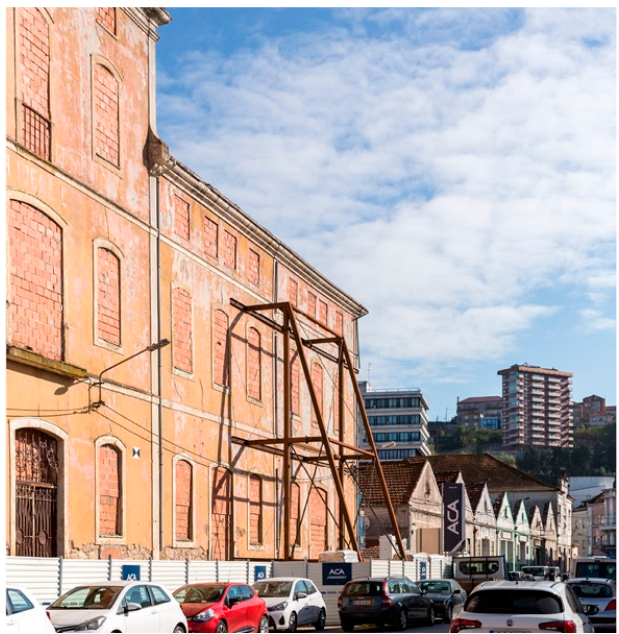
Figure 17. Coimbra. Old factory. ©João Ferrand.